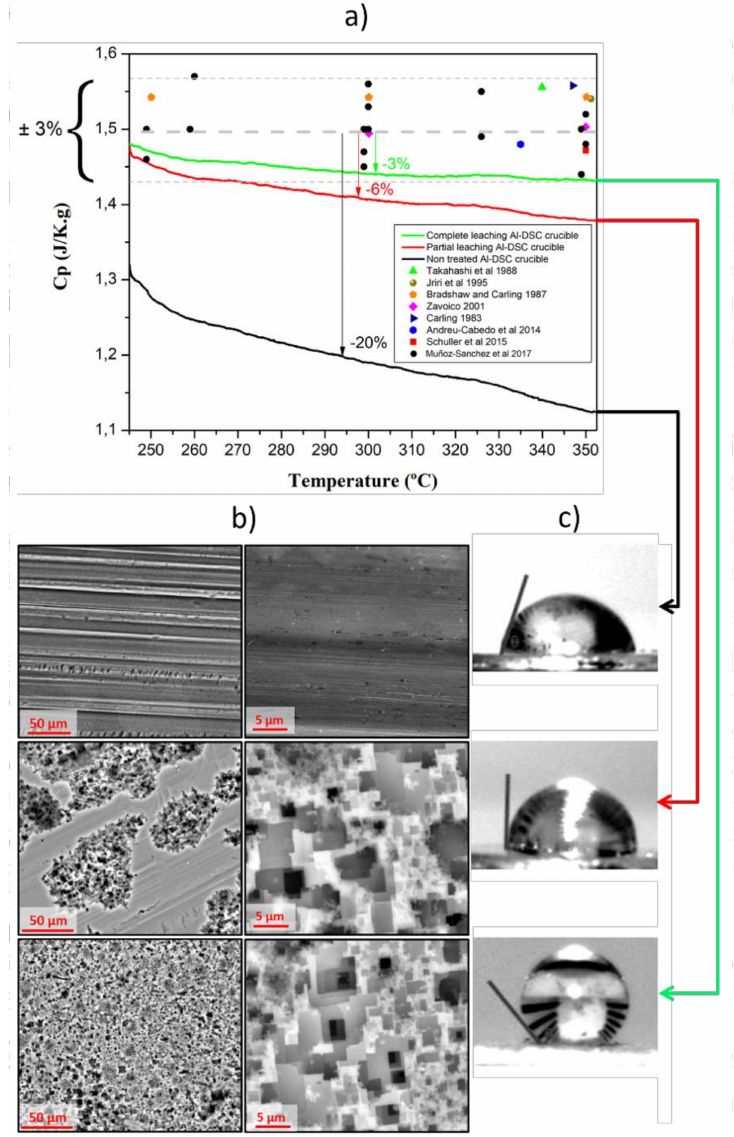
Figure 2. ( a ) Heat capacity of Solar salt, ( b ) SEM images of the crucible surface and ( c ) contact angle of Solar salt on the surface of the DSC crucible at 300 ◦ C for the cases of pristine non-treated Al-DSC crucible (bottom), partially leached Al-DSC crucible (middle) and completely leached Al-DSC crucible